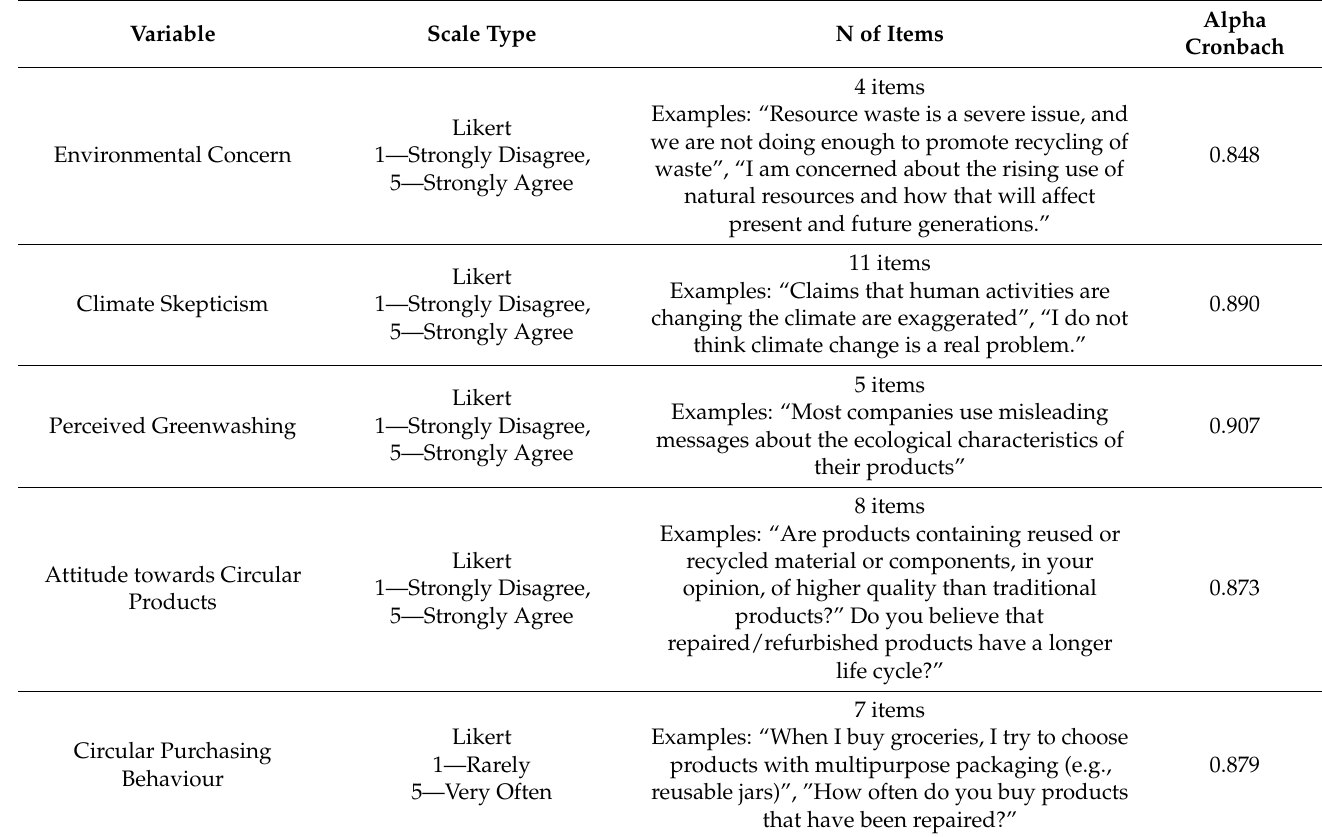
Table 2. Measurement instruments and their